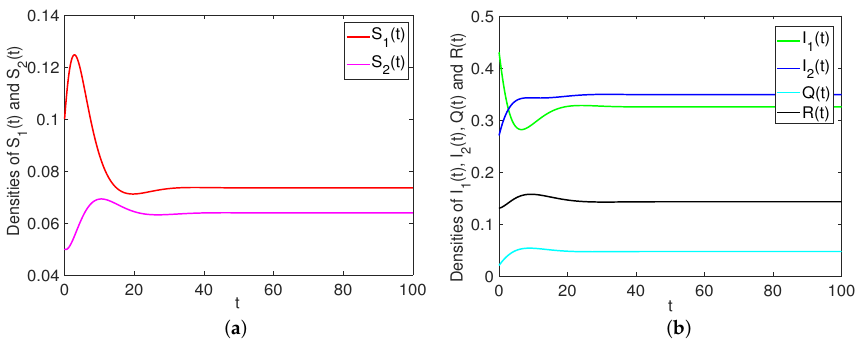
Figure 8. The dynamics of system (1) with (cid:60) 01 = 2.14 > 1 and (cid:60) 02 = 1.9 > 1. ( a ) The trajectories of S 1 ( t ) and S 2 ( t ) . ( b ) The trajectories of I 1 ( t ) , I 2 ( t ) , Q ( t ) and R ( t ) .